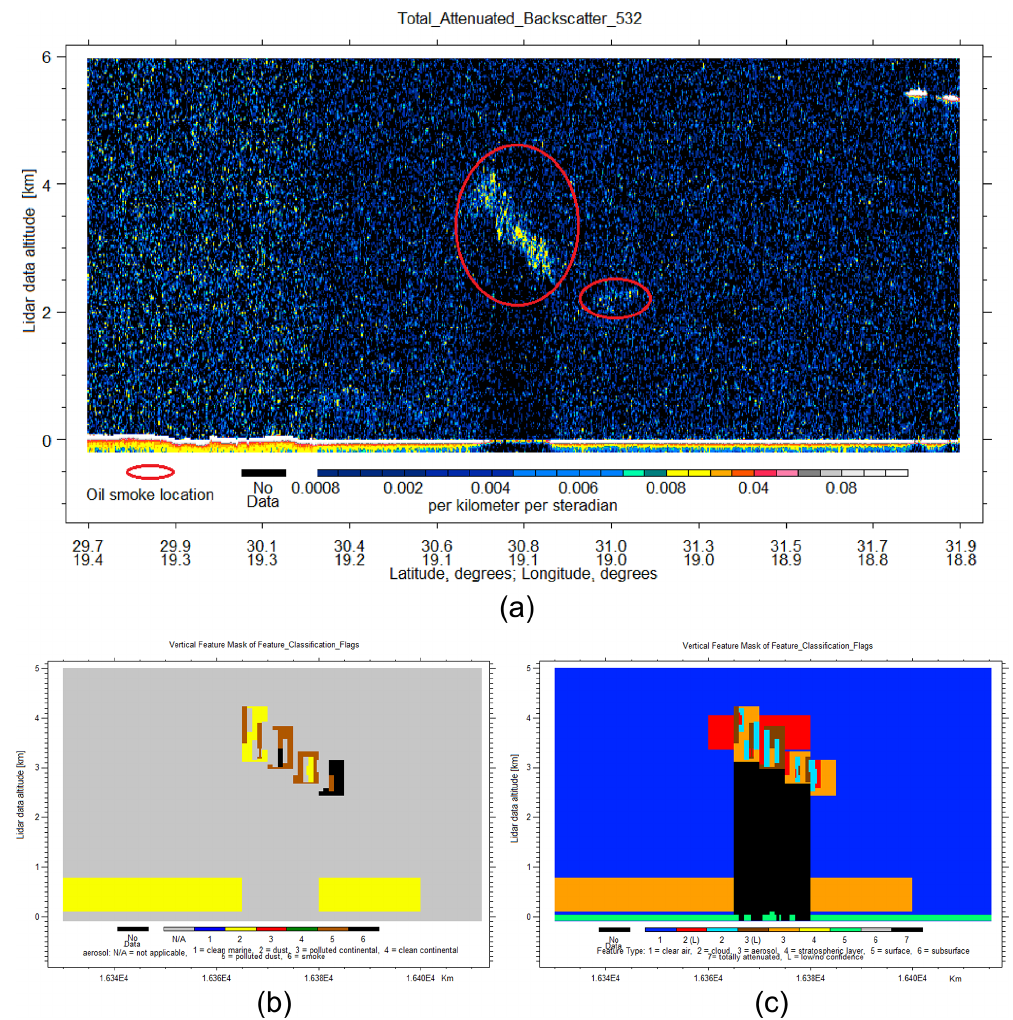
Figure 5. (a) Image of event 14 plume based on CALIPSO total attenuated backscatter (532nm) vs. lidar data altitude data. (b) Aerosol feature classification. (c) Cloud feature classification. Table 3. Mean and standard deviation values of aerosol properties (AOD, AE, R eff ) based on MODIS Terra successful